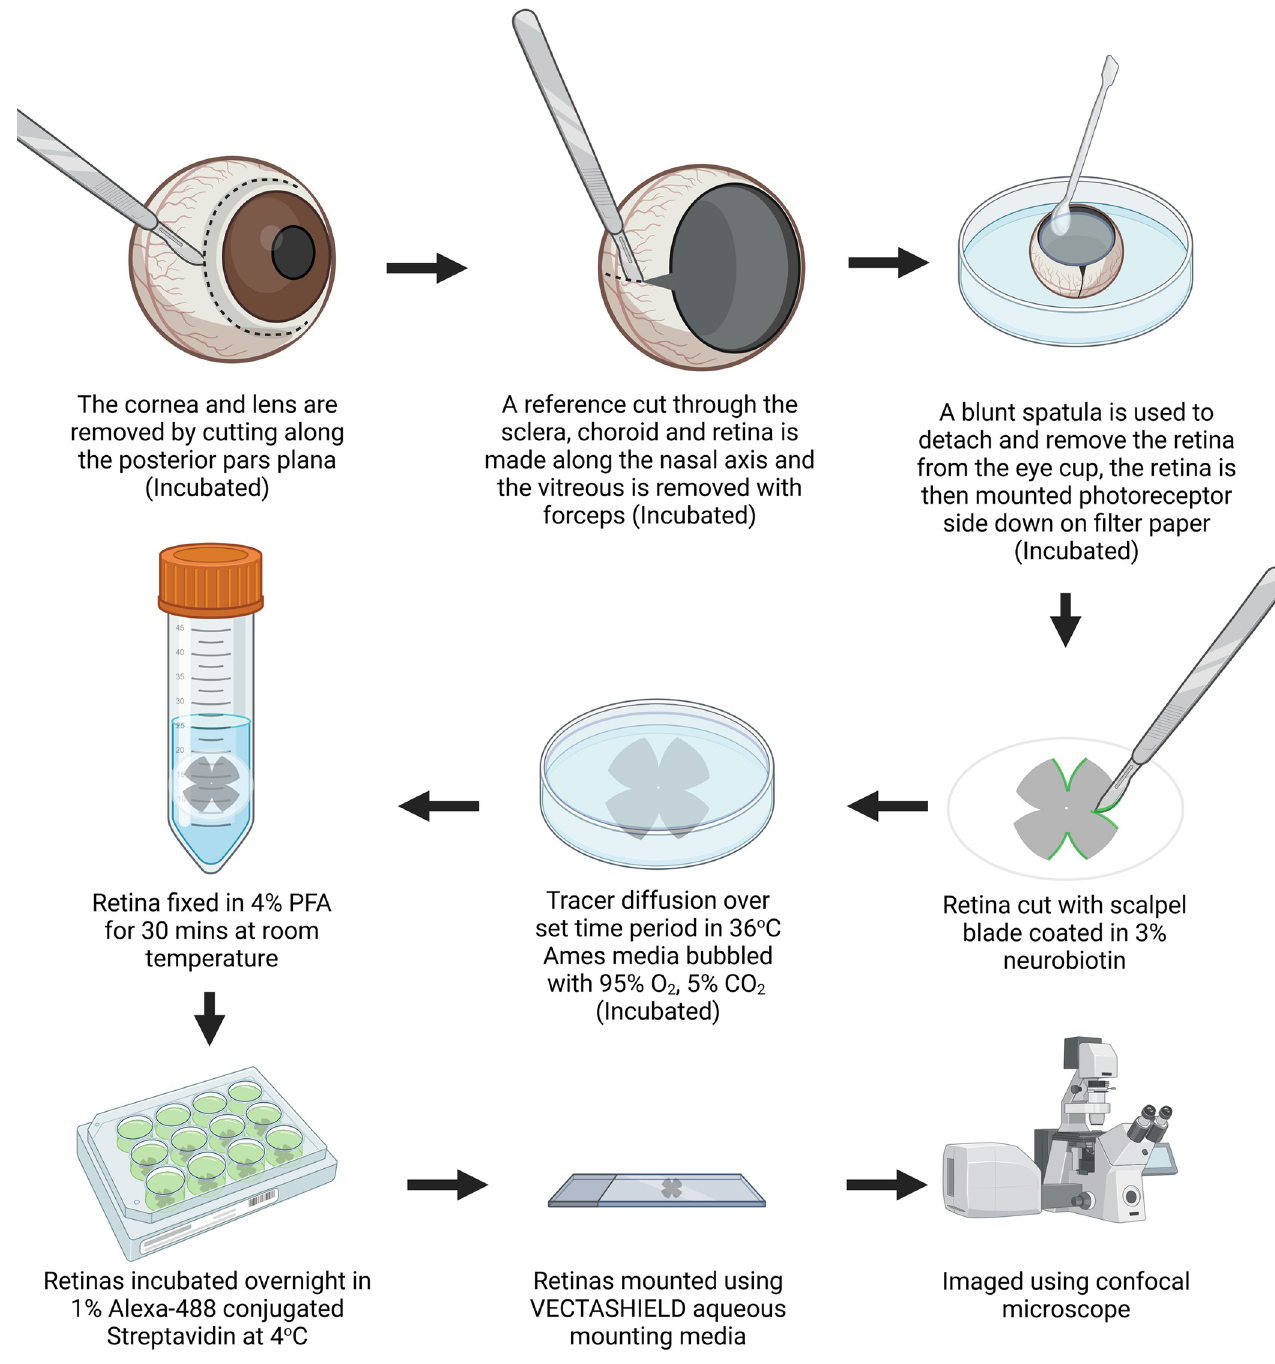
Fig 1. Flow chart illustrating the key steps in the cut-loading procedure. Figure made using the online application BioRender.com.